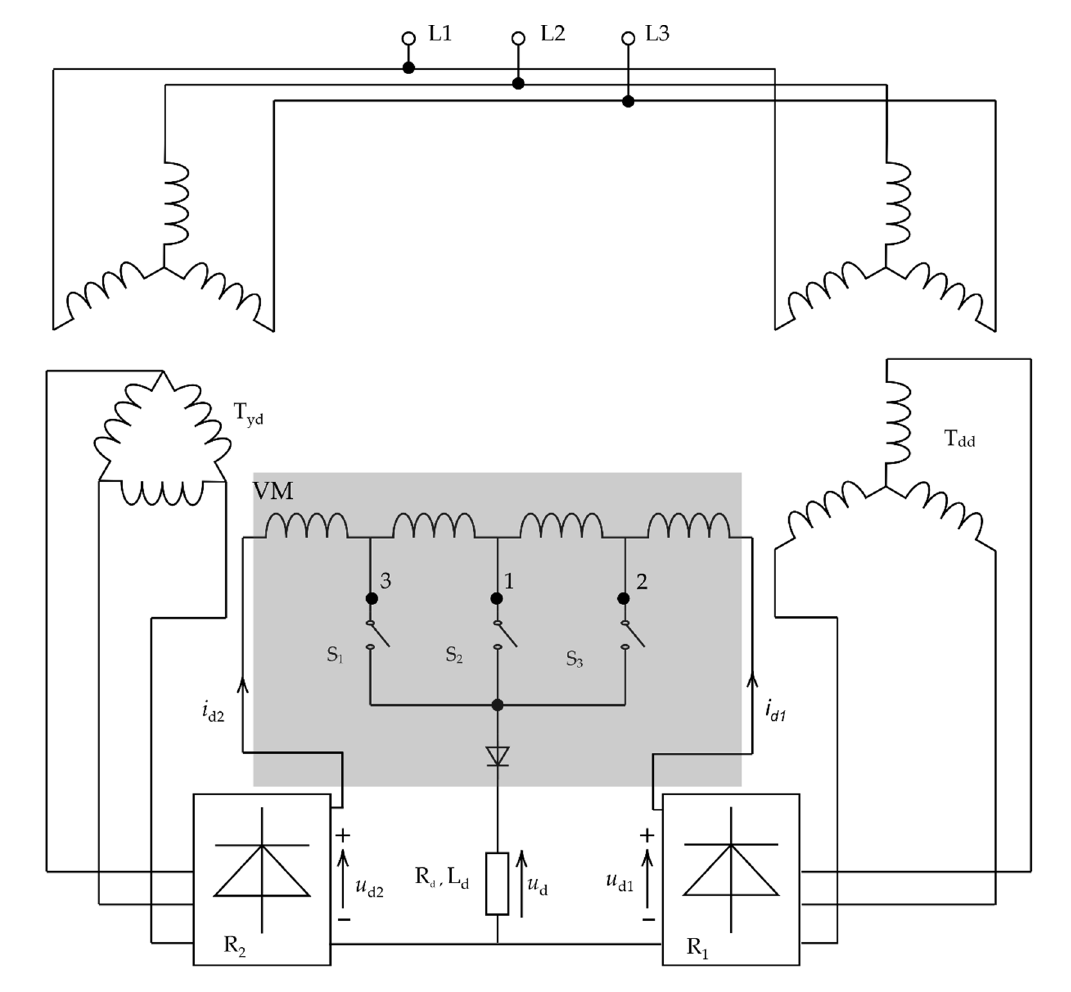
Figure 1. Circuit diagram of the rectifier system with the voltage modulator on the DC circuit side.